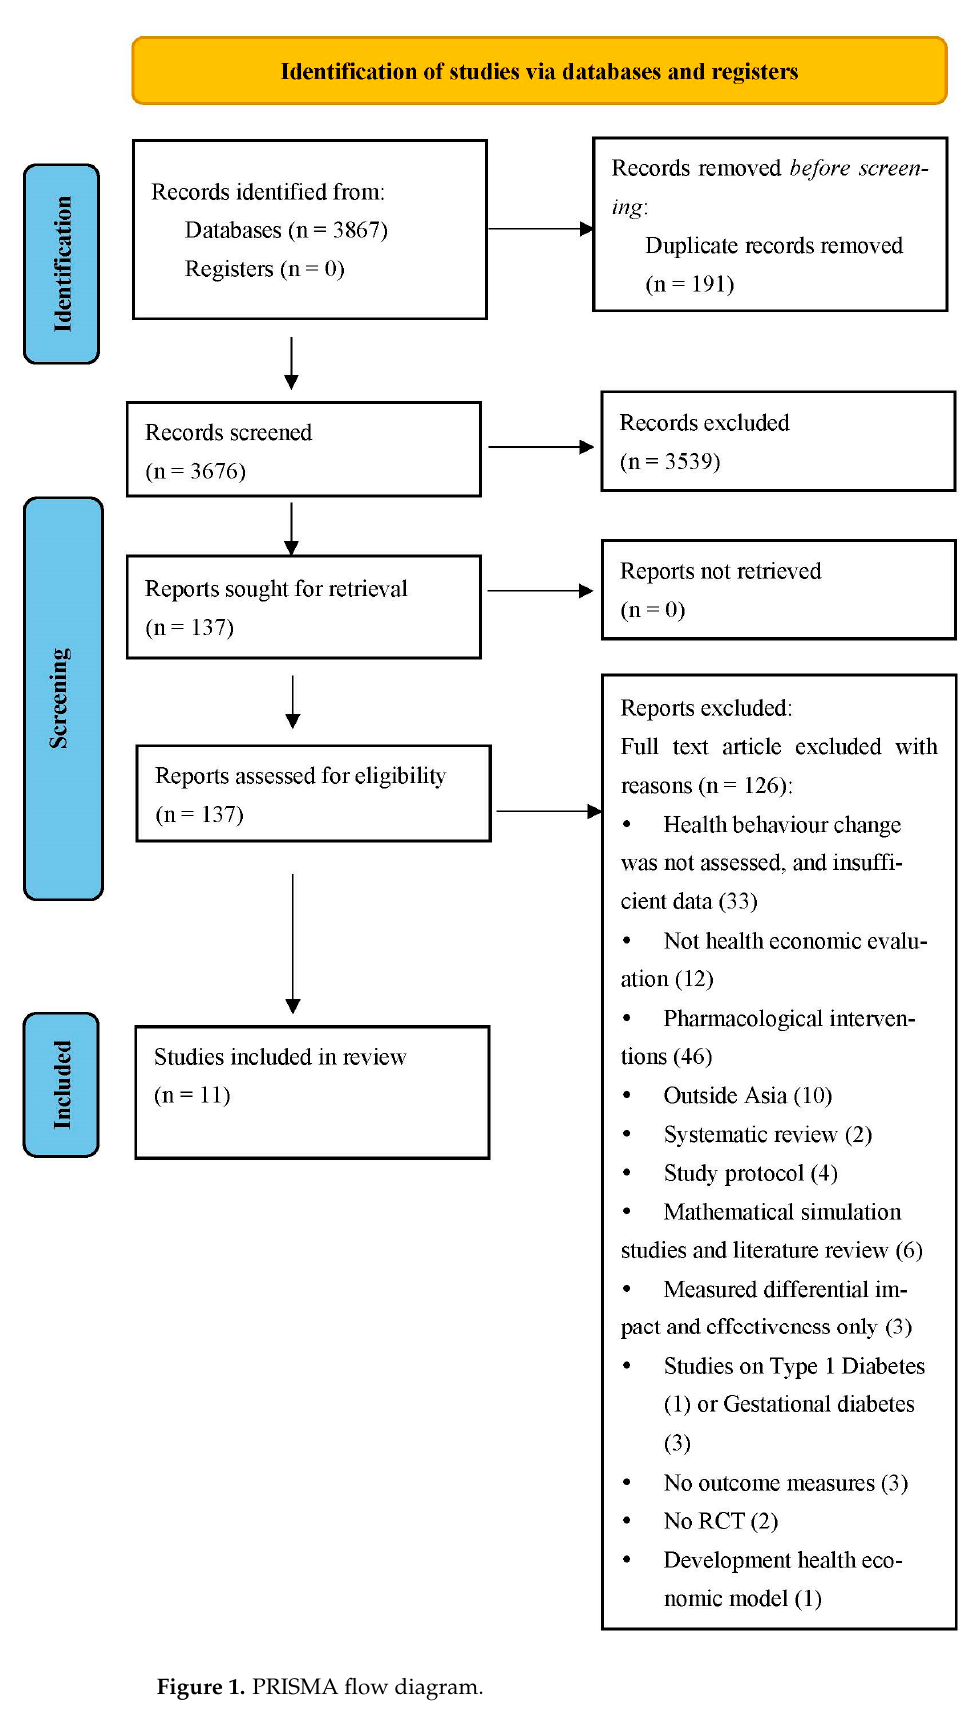
Figure 1. PRISMA flow